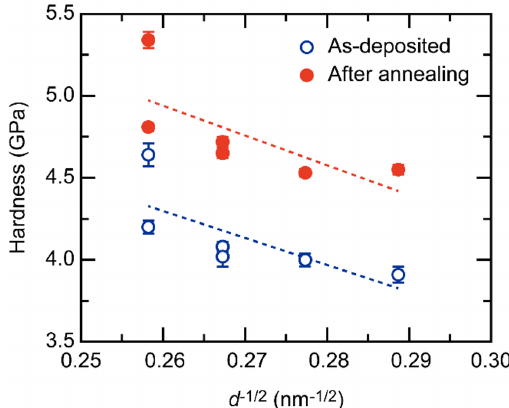
Figure 4. Hall-Petch plot of hardness for electrodeposited bulk nanocrystalline Fe-Ni alloys in an as-deposited state and after annealing at 200 °C for 3